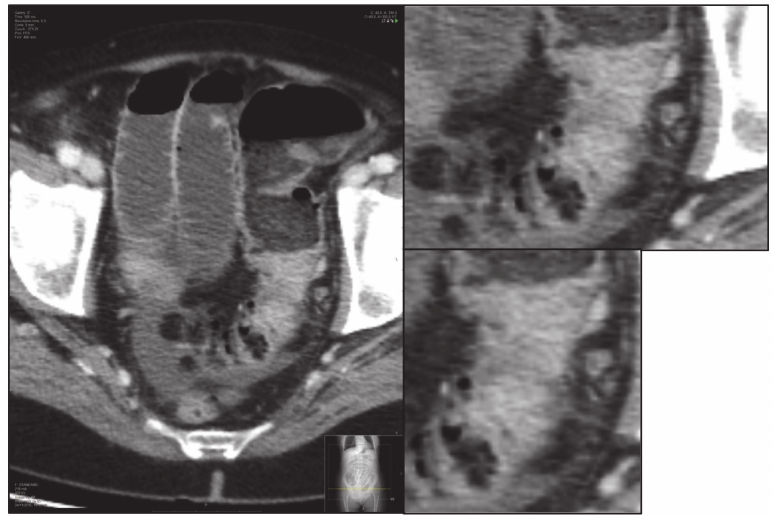
Figure 4. “Small-original”. In the two adjacent small images, the tumour can be seen in detail. In this case, the images have not